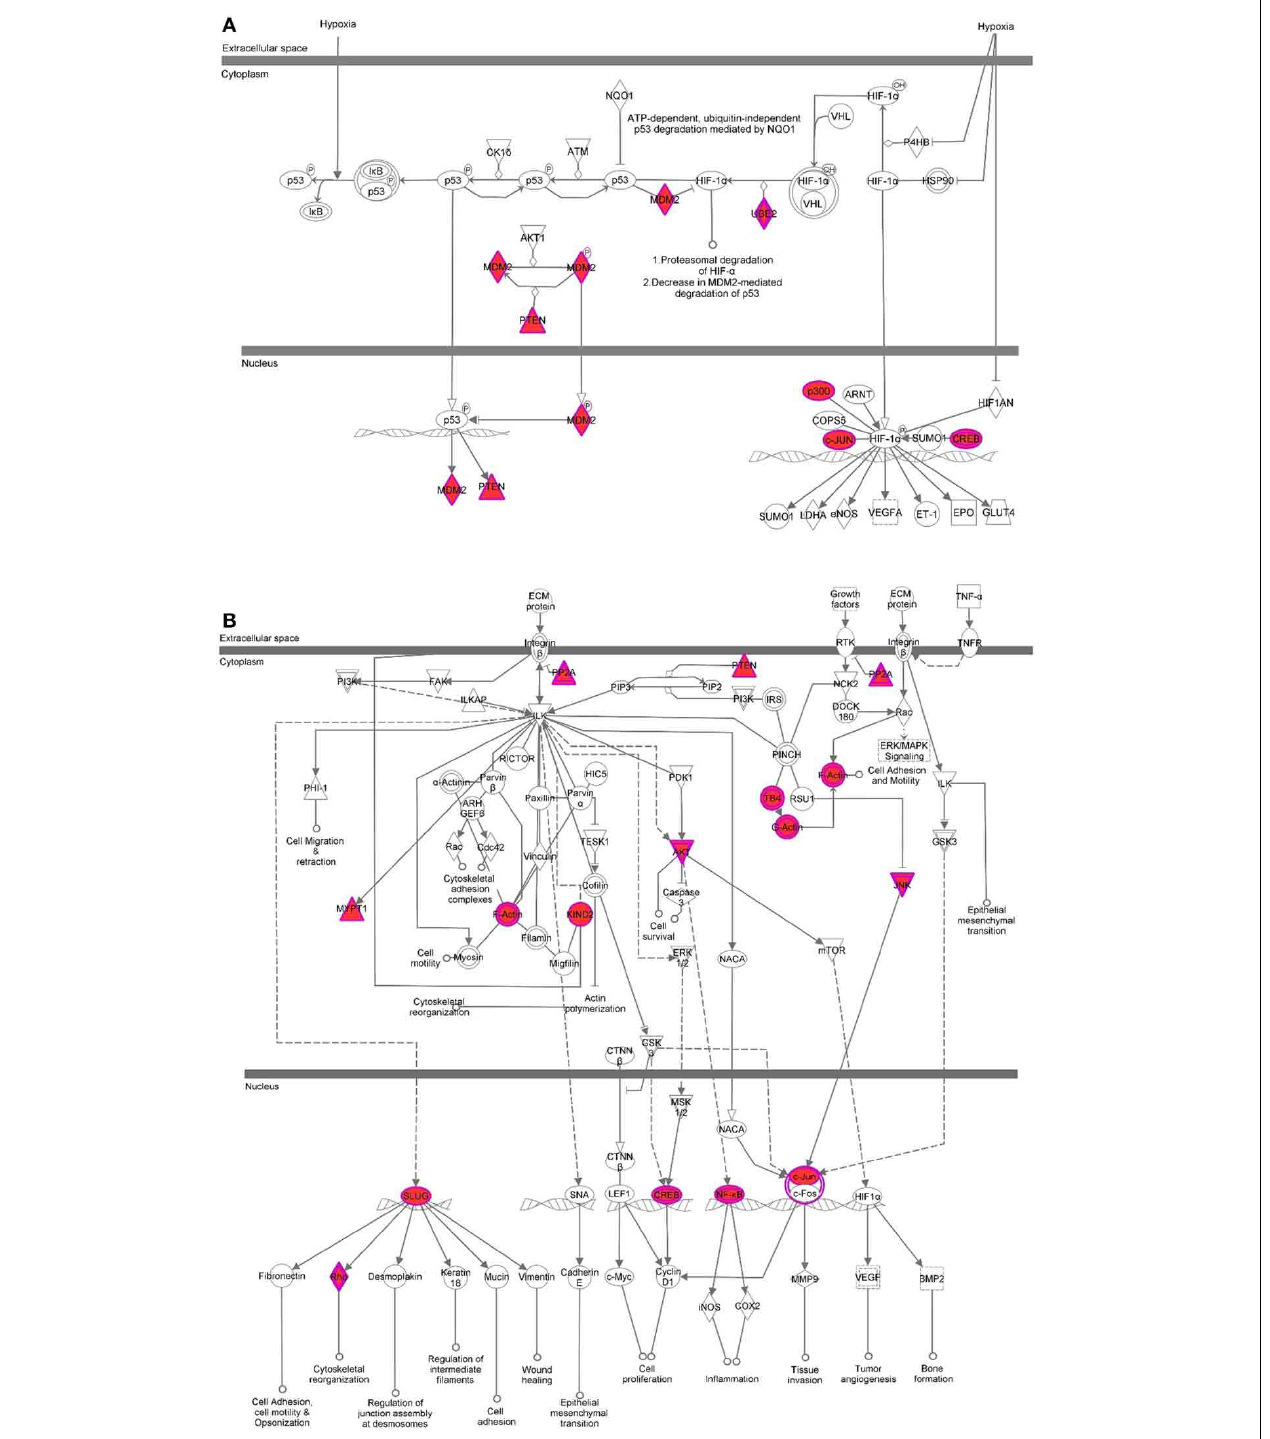
FIGURE 6 | Pathway analysis for H3K9me3 enriched genes in baboon SVZ cells. Top canonical pathways were predicted by Ingenuity Pathway Analysis software. The shaded focus genes (red highlight) were enriched with H3K9me3 identified by ChIP-Seq analysis. The node shape reflects the role of